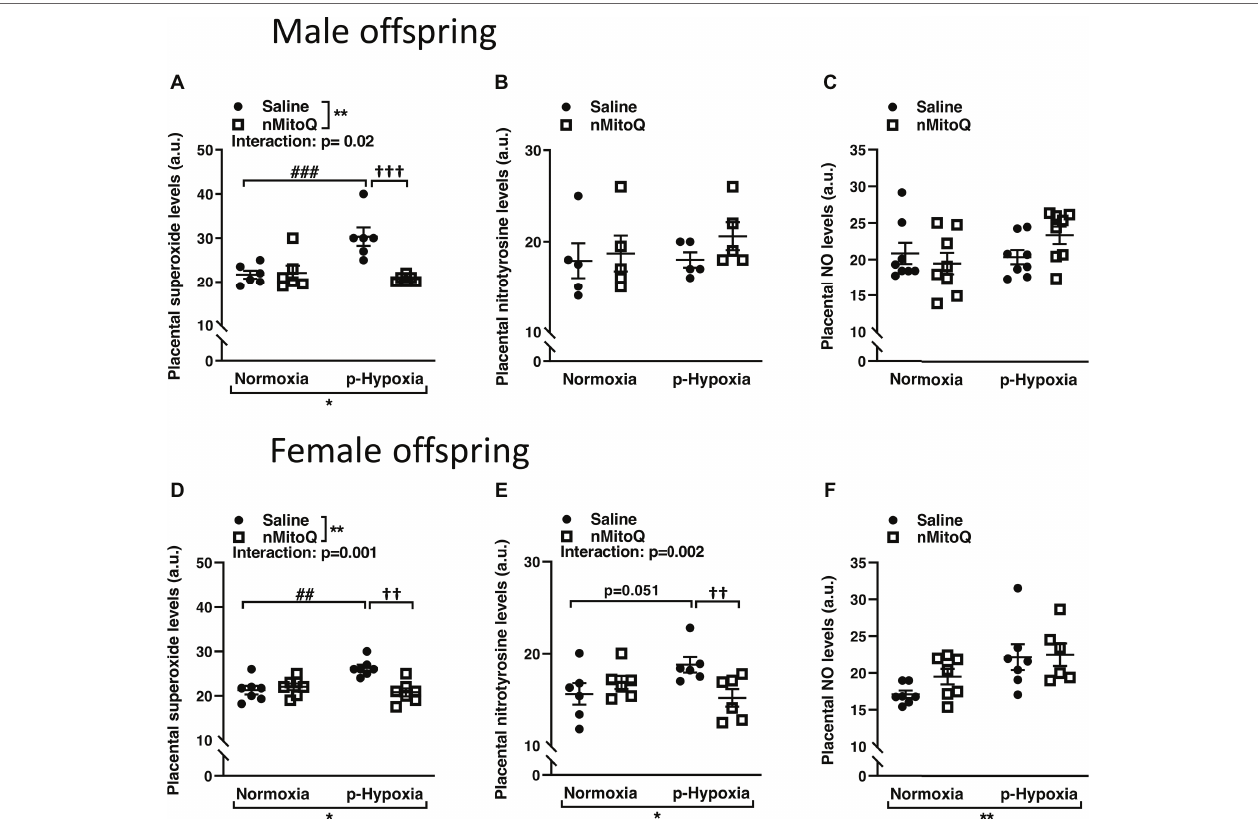
FIGURE 1 | Effects of nMitoQ treatment on placental superoxide, peroxynitrite, and NO levels in normoxic and hypoxic placentae of both male and female offspring. Normoxic and hypoxic dams were treated with nMitoQ or saline, and superoxide levels were assessed by DHE staining in placentae from male (A) and female (D) fetuses; peroxynitrite levels were detected by staining for nitrotyrosine (the footprint of peroxynitrite production) in placentae from male (B) and female (E) fetuses, and NO levels were assessed by DAF-FM staining in placentae from male (C) and female (F) fetuses on GD21. Data are represented as mean ± SEM. a.u.: arbitrary units. All groups were compared using a two-way ANOVA followed by Sidak’s post hoc test ( n = 6–7/group). * p < 0.05, ** p < 0.01 group effect of prenatal hypoxia or nMitoQ treatment; ## p < 0.01, ### p < 0.001 compared to normoxia-saline; †† p < 0.01, ††† p < 0.001 compared to hypoxia-saline group.